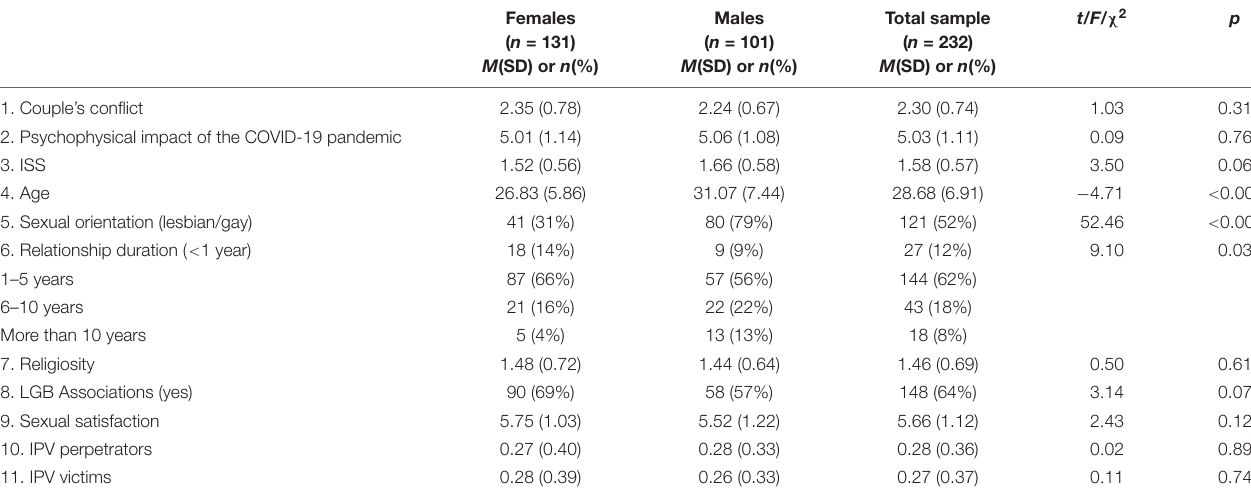
TABLE 1 | Descriptive (means, standard deviations, percentages) of the sample’s